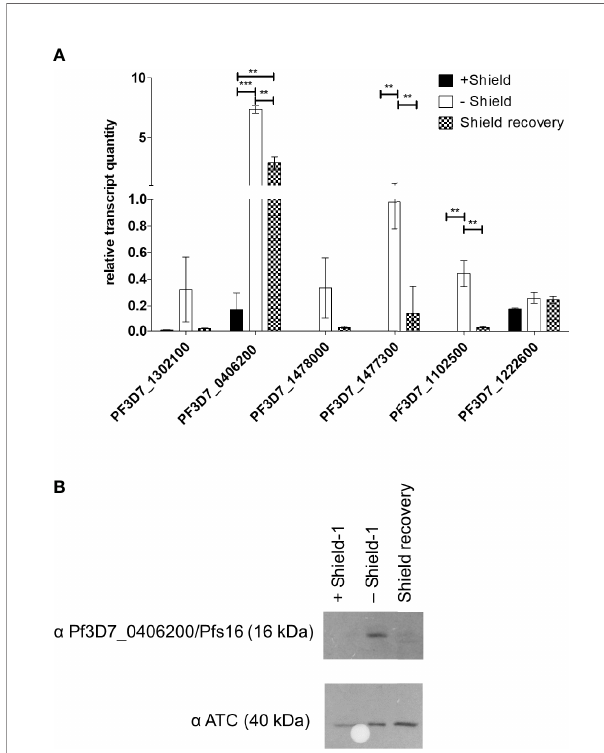
FIGURE 5 | PfAP2-O-GFP-HA-DD24 is involved in the transcription/ translation of gametocyte-related genes in P. falciparum . (A) Transcript abundance of gametocyte-stage speci fi c genes in PfAP2-O-GFP-HA-DD24 expressing, knocked-down (two reinvasions without Shield-1), and recovered parasites (two reinvasion cycles without Shield-1, followed by two reinvasion cycles in the presence of Shield-1). The data were normalized to seryl-tRNA ligase (PF3D7_0717700), used as the internal control. For statistical evaluation, the ANOVA test with Bonferroni ’ s correction was used. ** is p < 0.01 and *** is p < 0.005. (B) Western blot detecting Pfs16/Pf3D7_0406200 in extracts of NF54::PfAP2-O_GFP_HA_DD24 parasites in the three conditions (on Shield-1/knocked-down/recovered parasites). As a control, an anti-ATC antibody was used as before. See Supplementary Figures for the full size